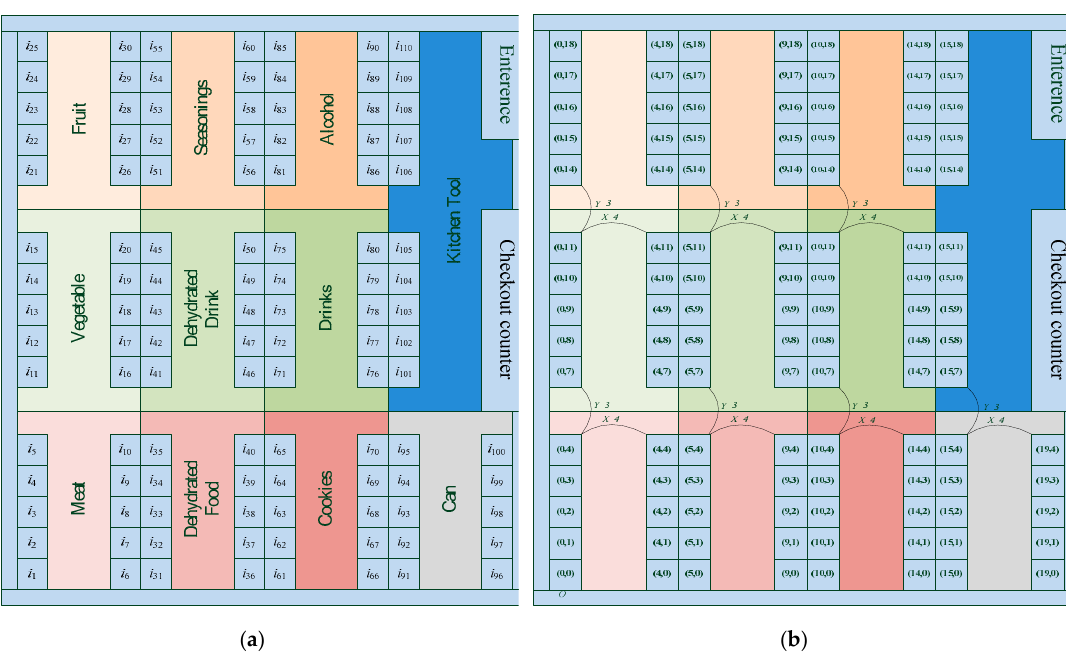
Figure 4. Simplified layout in the case study. ( a ) Initial product shelf assignment; ( b ) cell coordinates. Table 1. Four customer types and their purchase behavior.